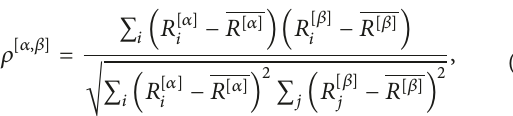
Figure 5 we plot the time evolution of the average participa- tion coefficient 𝑃 𝐼 ( 𝑥 -axis) of stocks in the industrial sector 𝐼 against the average overlapping degree 𝑜 𝐼 ( 𝑦 -axis). Each circle corresponds to one of the 200 time windows, while the size and colour of each circle represent different time windows. Each panel corresponds to one industrial sector 𝐼 .